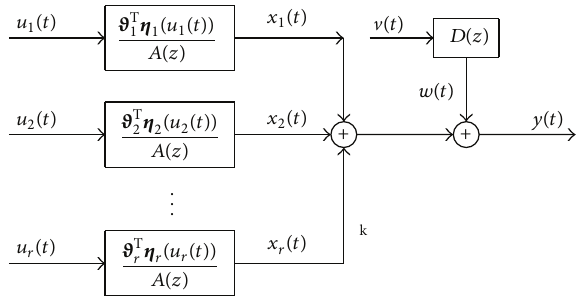
Figure 1: The linear-in-parameters multiple-input single-output output error moving average